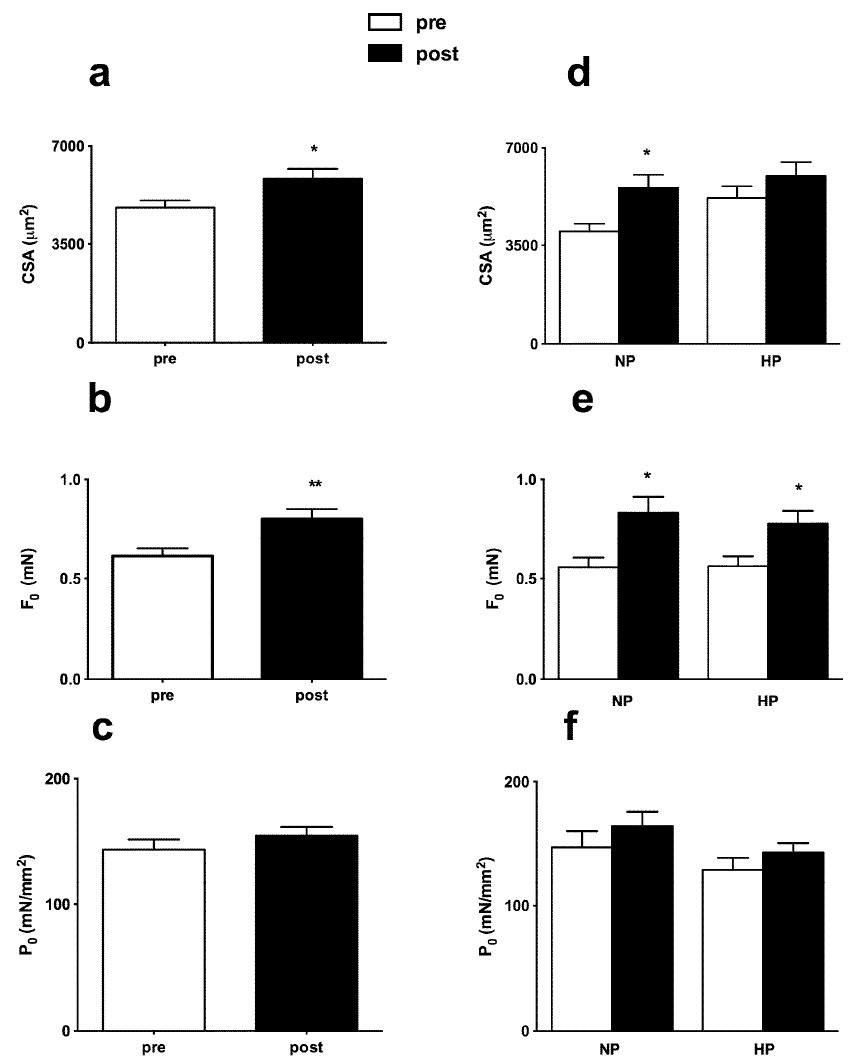
Figure 3. Effects of RT and protein supply (NP and HP) on Cross ‐ Sectional Area (CSA), Isometric Force (Fo), and Isometric tension (Po). Merged NP + HP data are shown in ( a – c ), while individual data for the NP and HP groups are shown in ( d – f ). A paired Student’s t ‐ test was used for merged data ( a , d ), while mixed ‐ model ANOVA (with one between ‐ subjects factor and one within ‐ subjects factor) was used for HP and NP analysis ( b , c , e , f ). Means and Standard Errors. * p < 0.05; ** p < 0.005 (pre ‐ vs. post ‐ ).